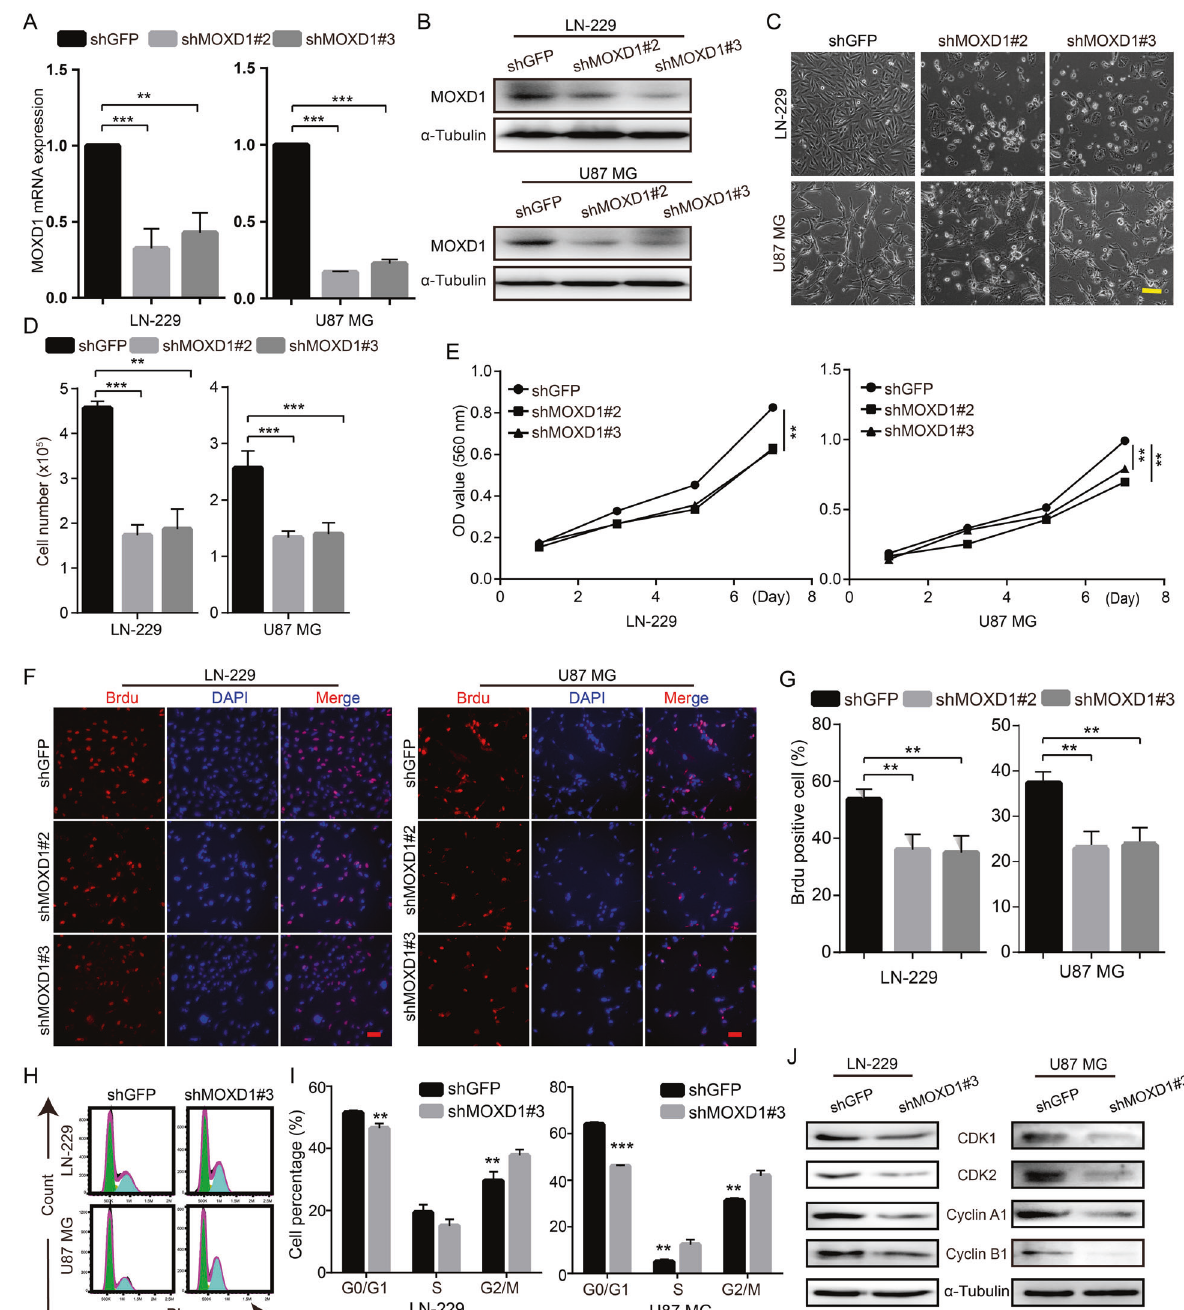
Fig. 2 Blocking MOXD1 inhibits GBM cell proliferation and induces cell arrest. A After MOXD1 knockdown by shRNA in GBM cell lines (LN- 229, U87 MG), MOXD1 expression was detected using qRT-PCR. B After MOXD1 knockdown by shRNA in GBM cell lines (LN-229, U87 MG), MOXD1 expression was detected using Western blot analysis. C One thousand cells were tiled in a six-well plate and the morphology of the cells was observed after culturing for 48 h. D One thousand cells are fl attened into a six-well plate, and the number of cells is counted after culturing for 48 h. E MOXD1 knockdown inhibited the proliferation of LN-229 and U87 MG cells, MTT assay was used to examine the effect of MOXD1 knockdown on cell viability. F BrdU assays was used to detect the DNA synthesis ability after MOXD1 knockdown. G The statistics of the amount of DNA synthesis of LN-229 and U87 MG cells ability after MOXD1 knockdown. H Cell cycle was assessed by fl ow cytometry after MOXD1 knockdown. I Statistics of each cycle of the cell after MOXD1 knockdown. J Western blot assay was executed to detect the expression of G2/M cell cycle regulatory proteins in MOXD1 knockdown have shown that N-glycosylation on glycosyltransferases is glycosidic bonds [16]. N-acetylglucosaminyltransferases which required for their proper-folding and/or enzymatic activities catalyze the initial branching and elongation reactions involved [18, 19]. The study showed that the knockdown of N- in the synthesis of O-linked oligosaccharide chains, and make the acetylglucosaminyltransferase-II suppresses tumorigenicity of protein undergo glycosylation modi fi cation [17]. Some studies